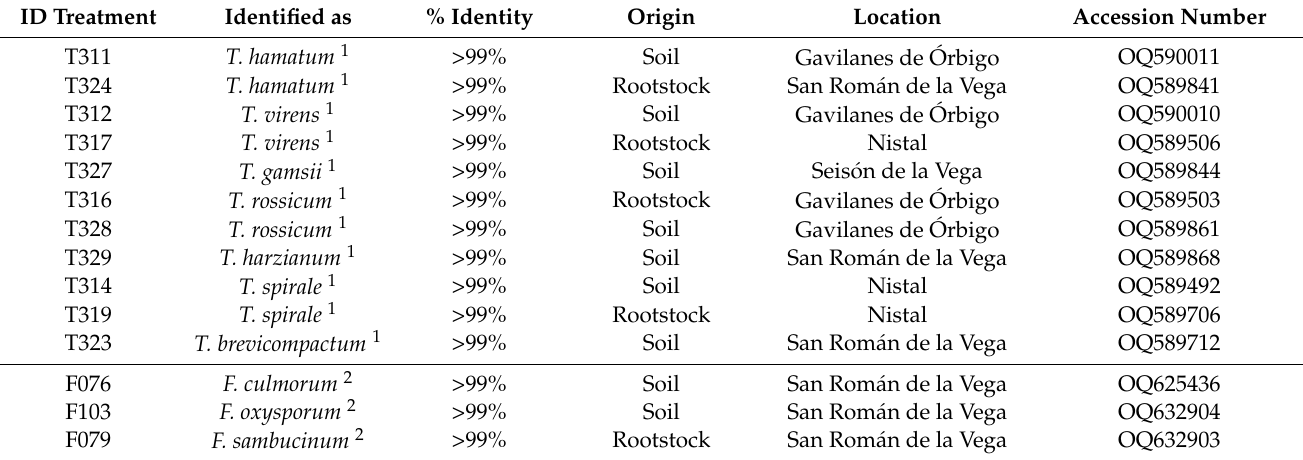
Table 1. Trichoderma and Fusarium isolates collected from hop-producing plots in Le ó n